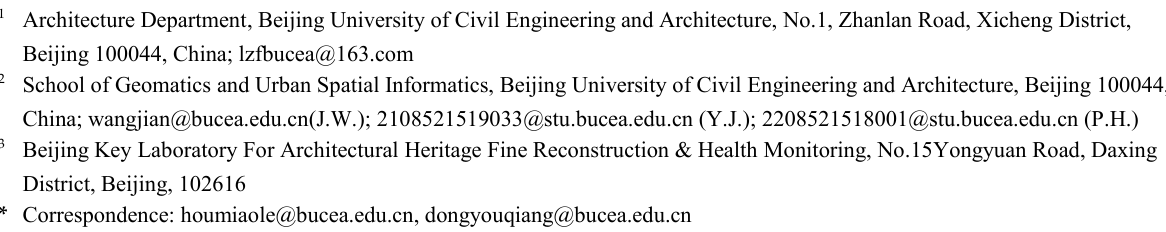
Figure 1. ( a )Location of the Nine-eyes watchtower; ( b ) The status of the Nine-eyes watchtower; ( c ) The collapsed parts of the Nine-